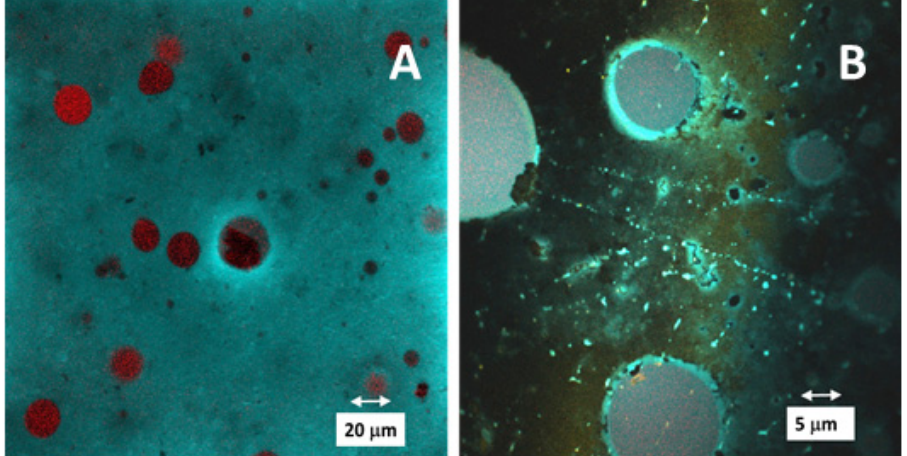
Figure 4. CLSM micrographs of O/W/O emulsion captured 7 days after preparation. Images represent sample areas followed at 467 nm ( A ) and at 580 nm ( B ). The excitation wavelength was 405 nm, with emission filters set 415–500 nm, and 540–600 nm.